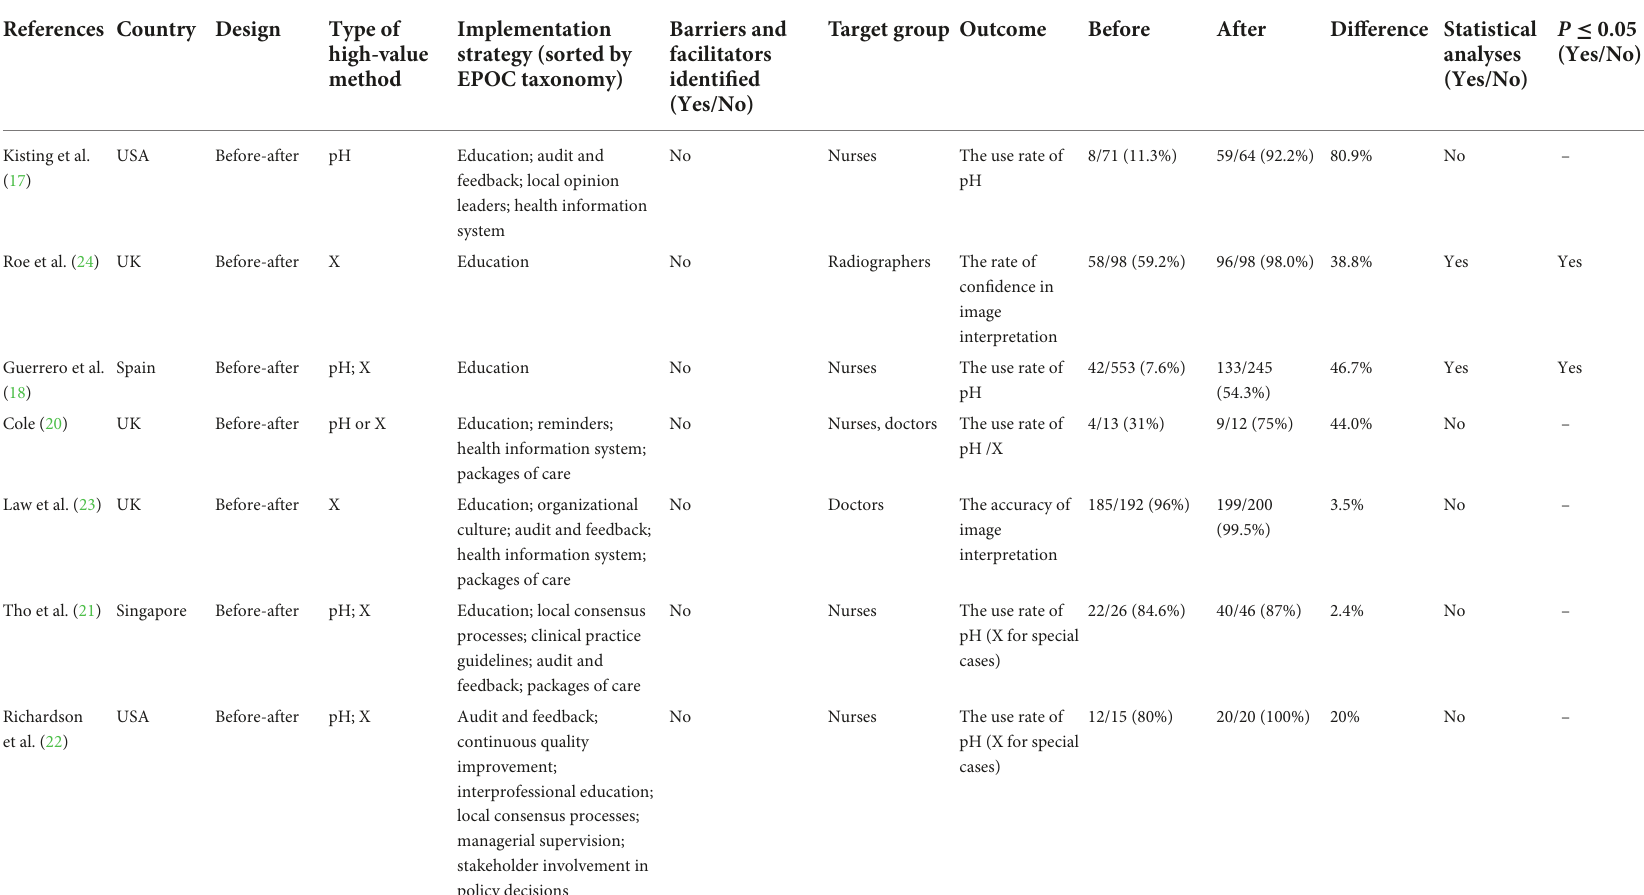
TABLE 2 Characteristics of the included studies ( n =